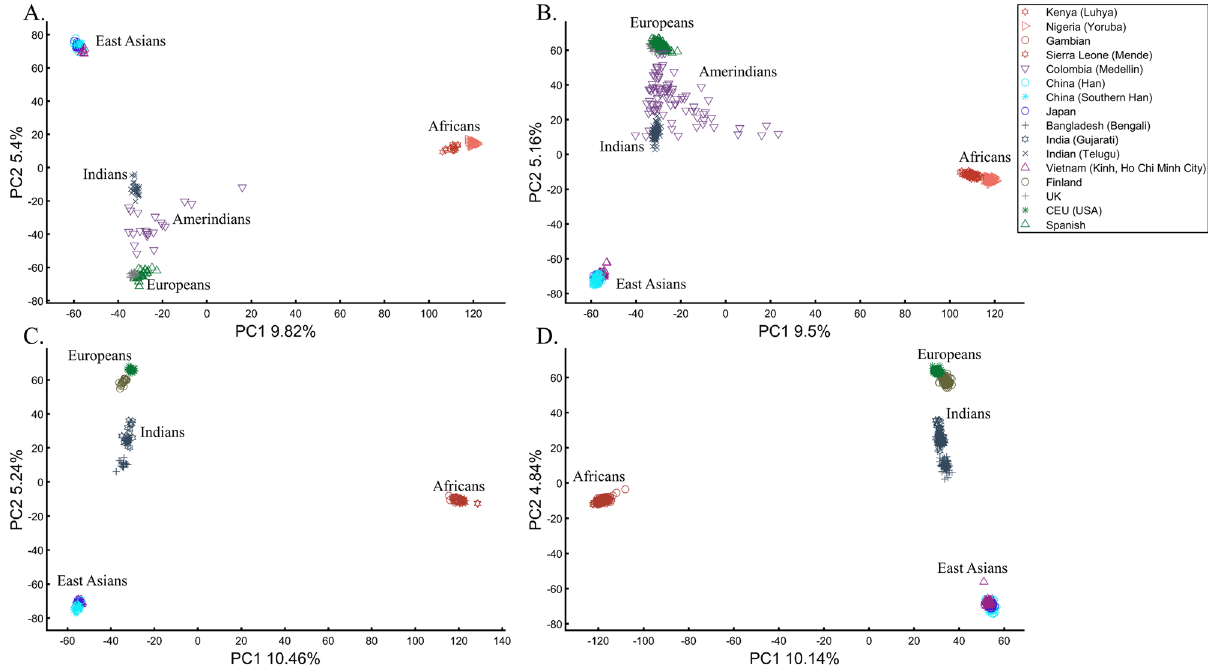
Figure 2. Testing the effect of even-sample sizes using two population sets. The top plots show nine populations with n = 50 ( A ) and n = 188 ( B ). The bottom plots show a different set of nine populations with n = 50 ( C ) and n = 192 ( D ). In both cases, increasing the sample size did not alter the PCs (the y-axis flip between ( C ) and ( D ) is a known